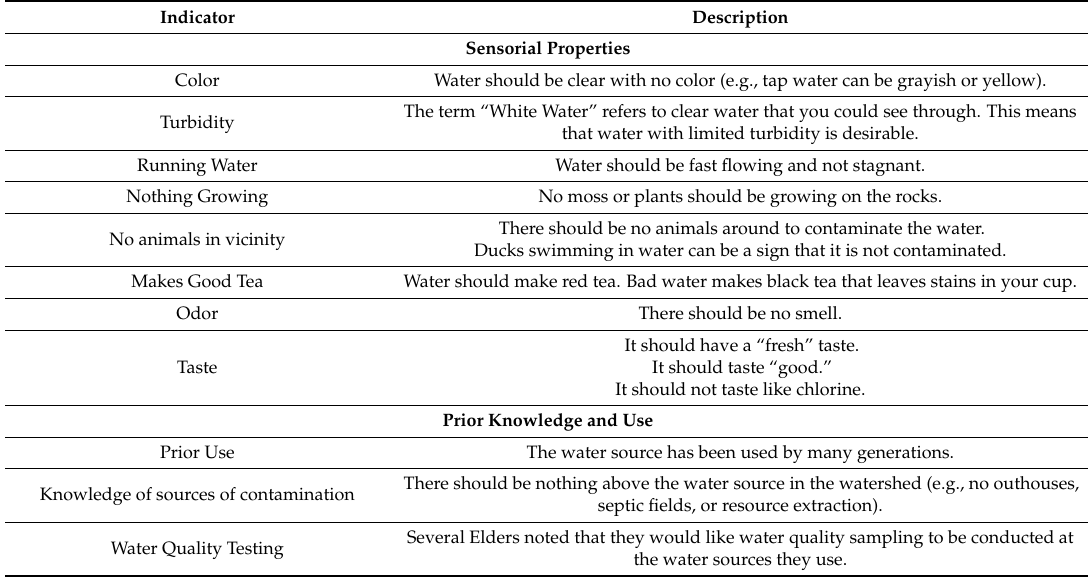
Table 1. Summary of indicators used by TH Elders to determine if traditional drinking water sources are safe for human